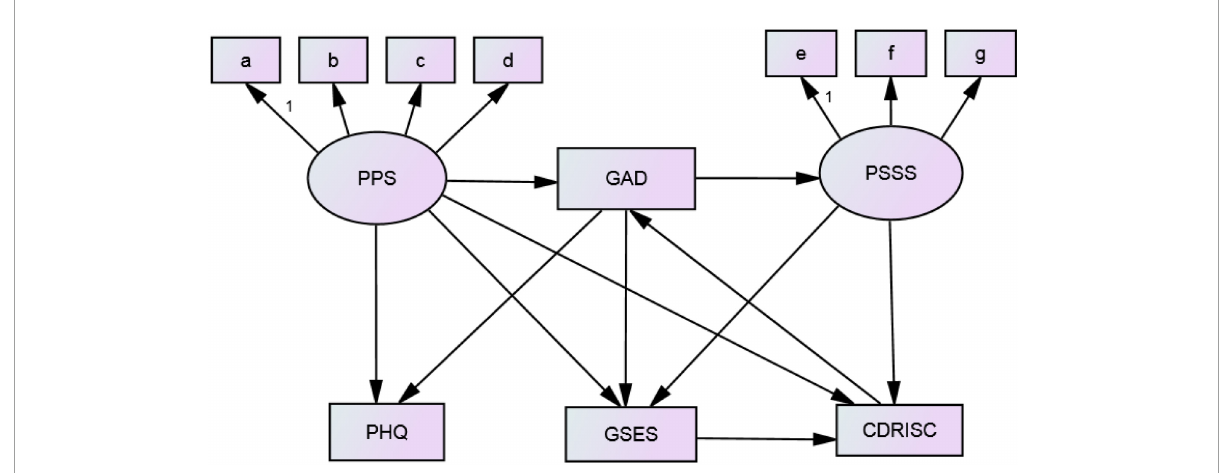
FIGURE1 Theoretical model of path analysis of positive psychology and negative emotion of pregnant women.